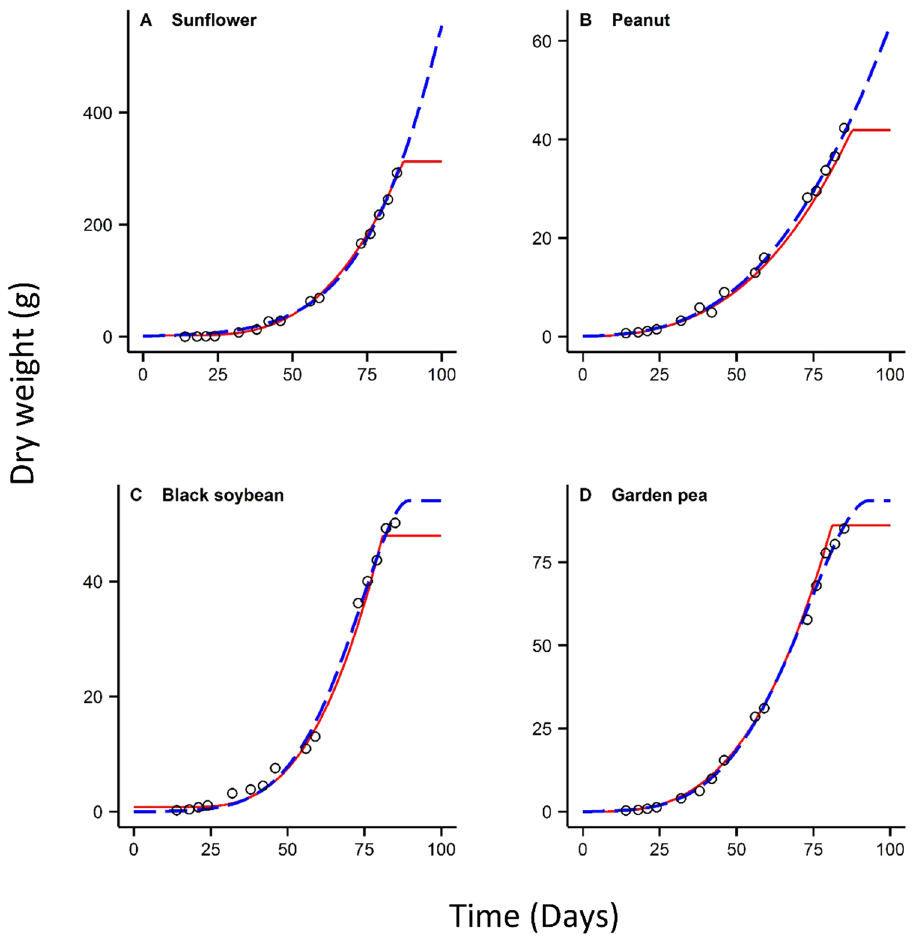
Figure 1. Comparison of fitted growth curves of the new growth model and the beta growth model for the growth datasets of sunflower, peanut, black soybean and garden pea. Circles represent the actual biomass observed. Red lines and black dashed lines represent the fitted curves of the new sigmoidal growth model and the beta sigmoidal growth model,